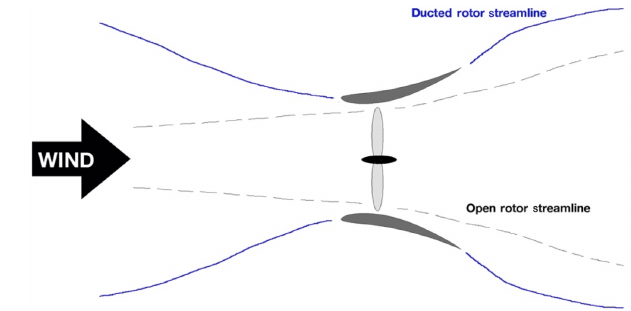
Figure 2. Commercial attempts at large ducted turbines: (a) Vortec 7; (b) Ogin